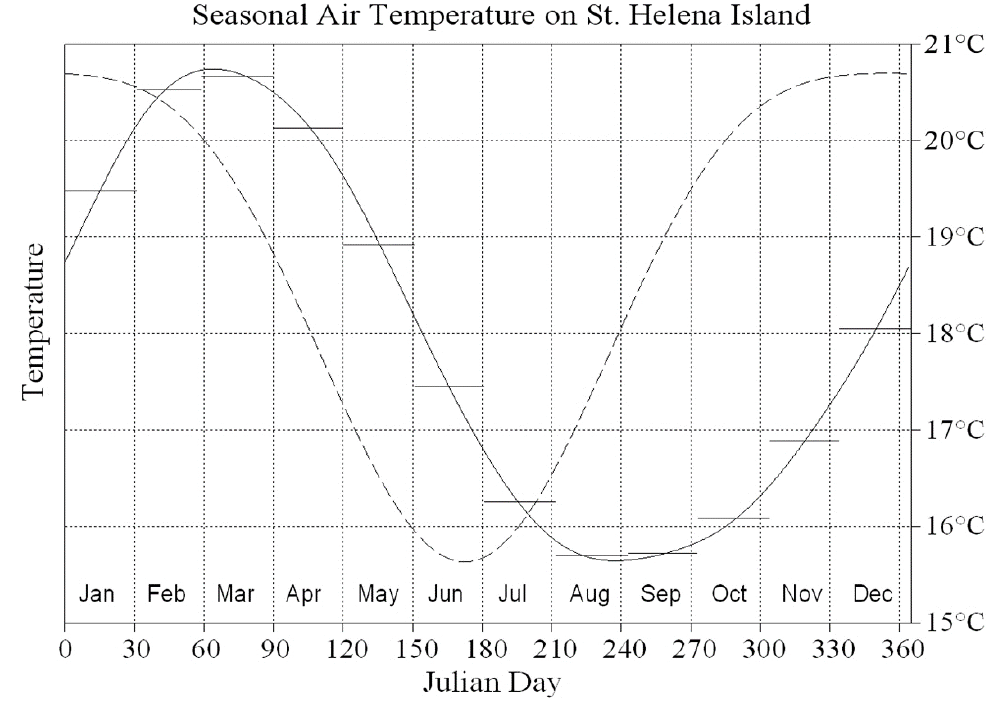
Figure 7. Climatological seasonal cycle 1893-1999 of the air temperature at St. Helena Island in the South Atlantic, converted to sea level [65]. Horizontal steps show the monthly mean values; the smooth curve is a daily interpolation of those values. Dashed is a phase-true daily astronomical solar irradiation, scaled to the temperature range. The average delay between the two curves is 78 days. The extended radiation maximum from November until January result from the double passage of the solar overhead position between the Tropics of Cancer and